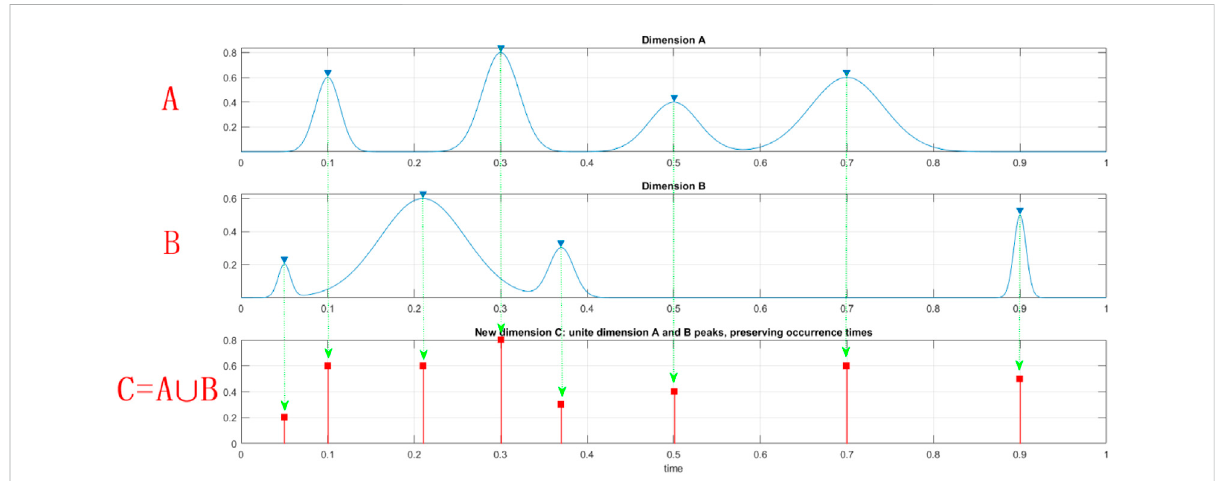
FIGURE 1 Illustration of synthetic (cid:2) R vector construction (process C), using two different dimensional processes ’ local maxima and overlapping them in